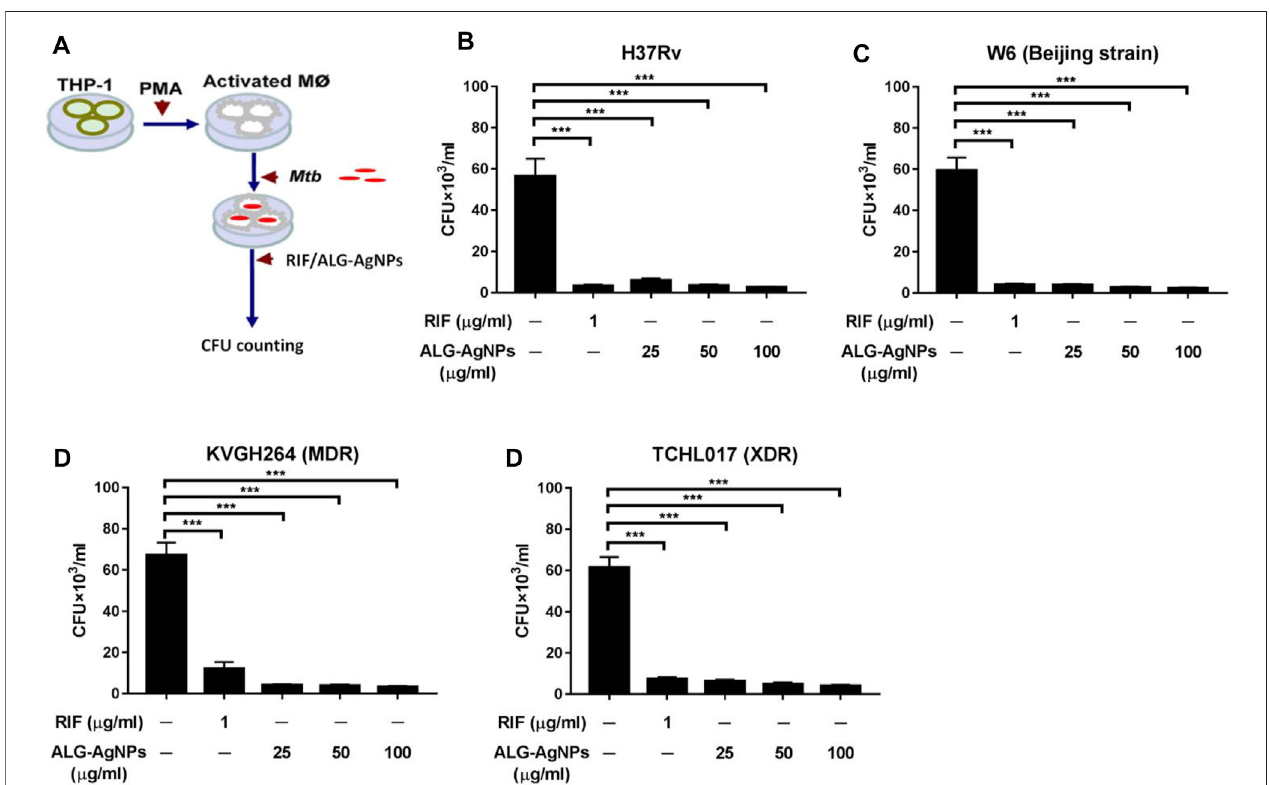
FIGURE 4 | ALG-AgNPs signi fi cantly inhibit the growth of cytosolic Mycobacterium tuberculosis in a macrophage infection model. (A) Schematic diagram of the experimentalprocedures. (B – E) THP-1cellsweredifferentiated intomacrophagesbyPMAstimulationfor3 days,theninfectedwithdifferentstrainsof Mtb ataMOIof1 for24 h.AftertreatmentwithPBS,ordifferentamountsofALG-AgNPs(25,50,and100 μ g/ml),orrifampicin(RIF)(1 μ g/ml)for5 days,thecellswerelysedandplatedon 7H10 agar plates. The bacterial growth was determined by CFU of (B) H37Rv, (C) W6 (Beijing strain), (D) KVGH264 (MDR), and (E) TCHL017 (XDR). MDR: Multidrug-resistant TB; XDR: extensively drug-resistant TB. Data represent mean ± SEM of 3 experiments. *** p < 0.001.